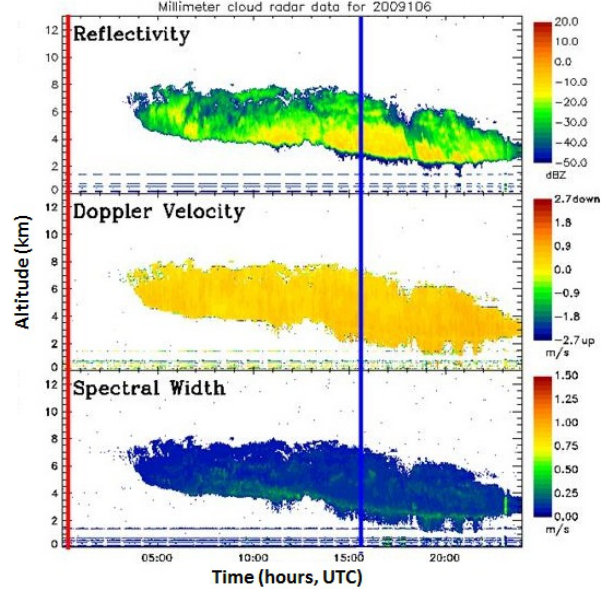
Fig. 7. MMCR reflectivity, Doppler velocity, and spectral width plots for 16 April 2009. Red and blue vertical bars correspond to the time of E-AERI measurements, at 00:08UTC and 17:57UTC, respectively, shown in Fig.